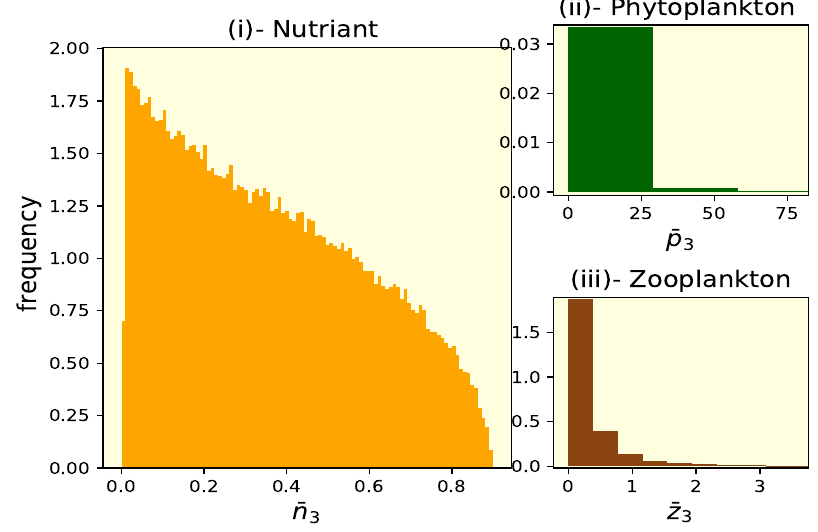
5 range from admissible parameters ( dist-equ3(n) in NPZ-